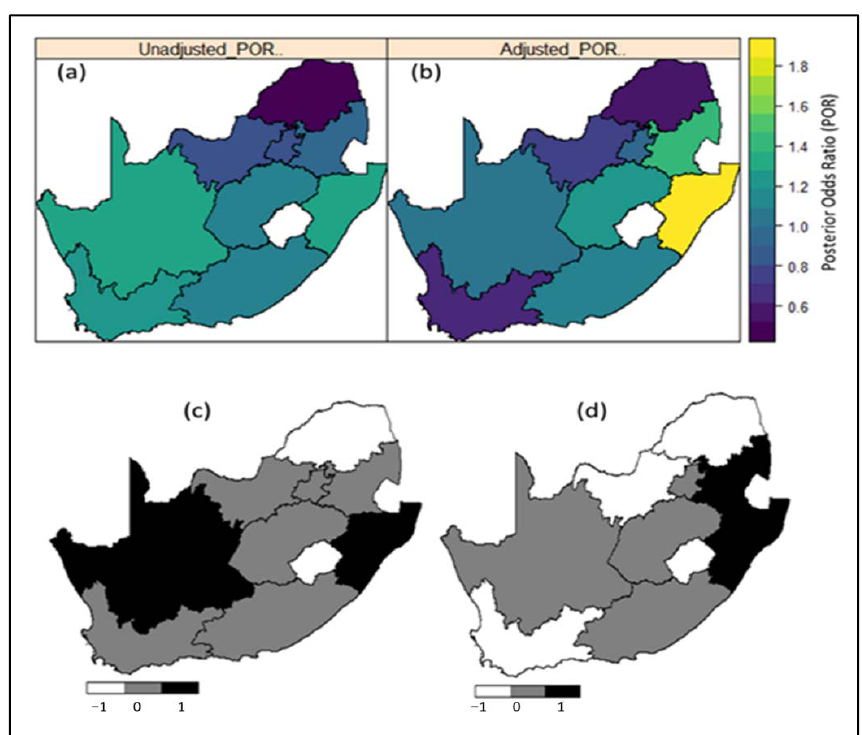
Figure 3. Estimates of mean posterior odds ratio (POR) of the spatial effects on prevalence of hypertension across the nine (9) provinces in South Africa based on ( a ) unadjusted model and ( b ) adjusted model; the corresponding significance maps of the posterior estimates based on 95% credible interval for ( c ) unadjusted model and ( d ) adjusted model. Evidence based on the 2016 DHS dataset. Note that in Figure 3, the central white patch (Lesotho) is excluded from the map. In Figure 3a,b, dark blue to yellow correspond to low risk to high risk provinces. In Figure 3c,d, black colour corresponds to significantly high risk regions; white colour corresponds to significantly low risk regions; and grey colour correspond to regions where the risks are not statistically significant.